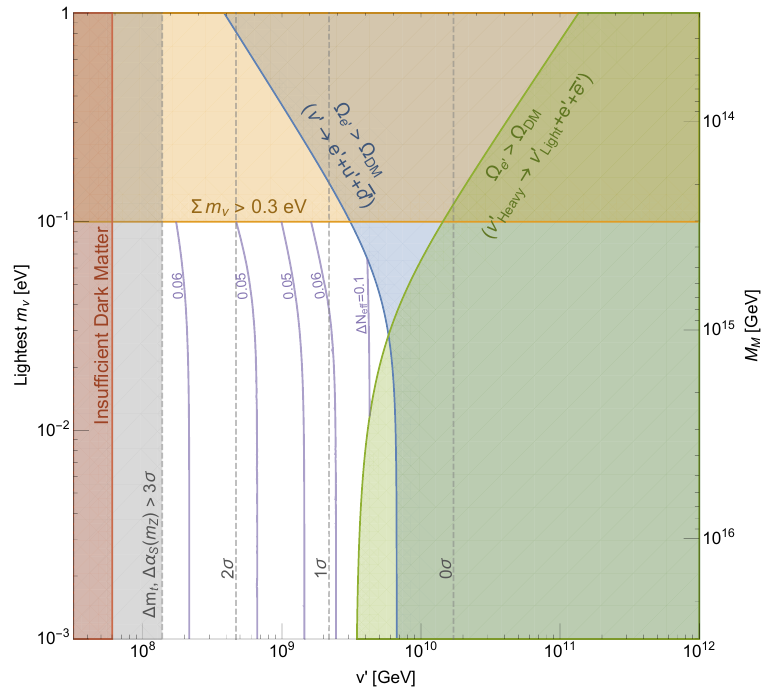
Figure 11 . Constraints on ( v 0 ; m (cid:23) ) when e 0 dark matter arises from freeze-out and dilution from (cid:23) 0 with universal neutrino portal couplings. Here m (cid:23) is the mass of the lightest neutrino. Purple contours show (cid:1) N e(cid:11) resulting from decays of S 0 to (cid:13) 0 . Vertical gray contours show v 0 when m t and (cid:11) S ( m Z ) deviate from their central values by 0 to 3 (cid:27) . In the allowed white region, (cid:1) N e(cid:11) is always greater than 0 : 03, which will be probed by CMB Stage IV